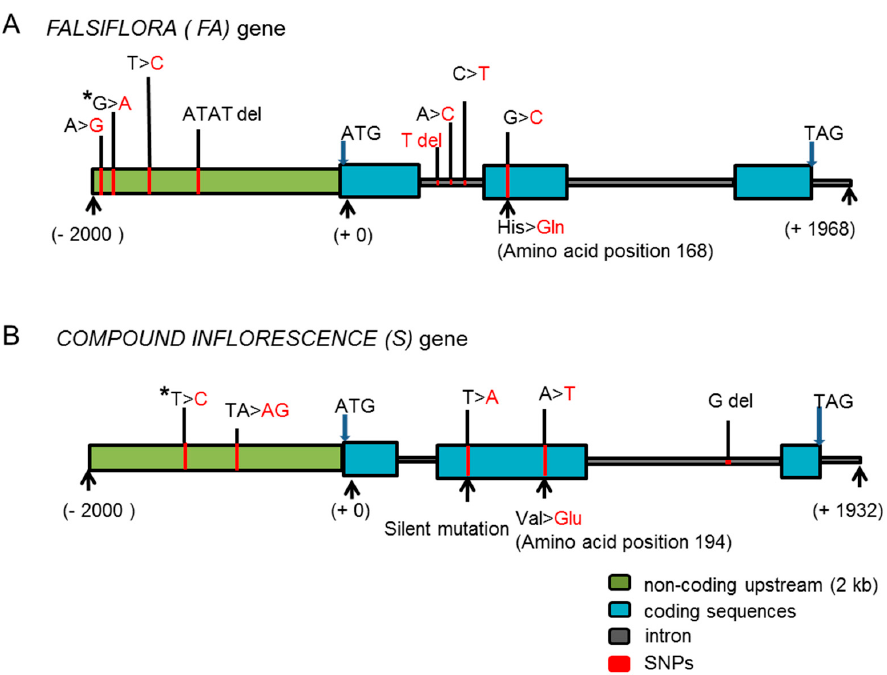
Figure 4. The structure and mutations of FA and S genes compared between the parents. ( A ) One amino acid substitution SNP (C/G, which changed the His in PI124039 to Gln in 10AS111A) identified in the second exon of the FA gene is indicated using an arrow; ( B ) two SNPs are located in the coding region, one a silent mutation, and the other changing Val in PI124039 to Glu in 10AS111A in the S gene. Exons are shown by blue boxes, introns are shown by grey lines, non-coding upstream regions (2 kb) are shown by green boxes, and the SNPs are shown by red lines. The SNPs in PI124039 are shown in black font and the one in 10AS111A is highlighted using red font. The SNPs marked by asterisk were designed as markers for HRM analysis of individuals of F 2 populations. del: deletion.